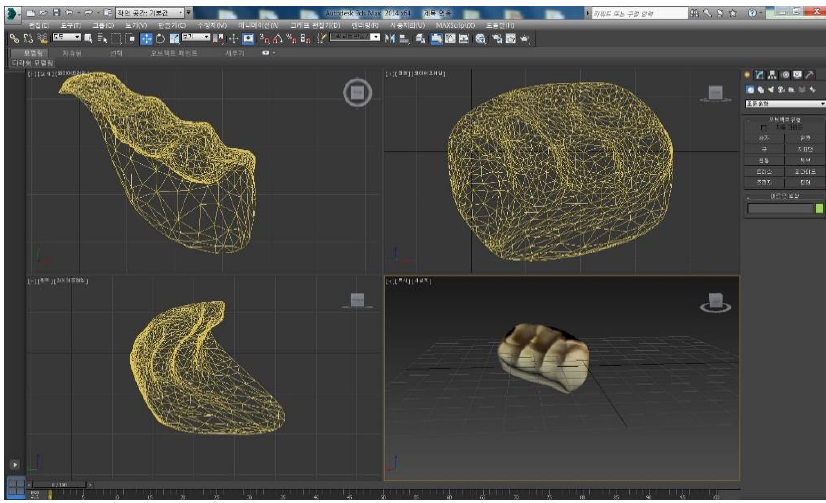
Figure 1. Precision laser probe 3D scanning.